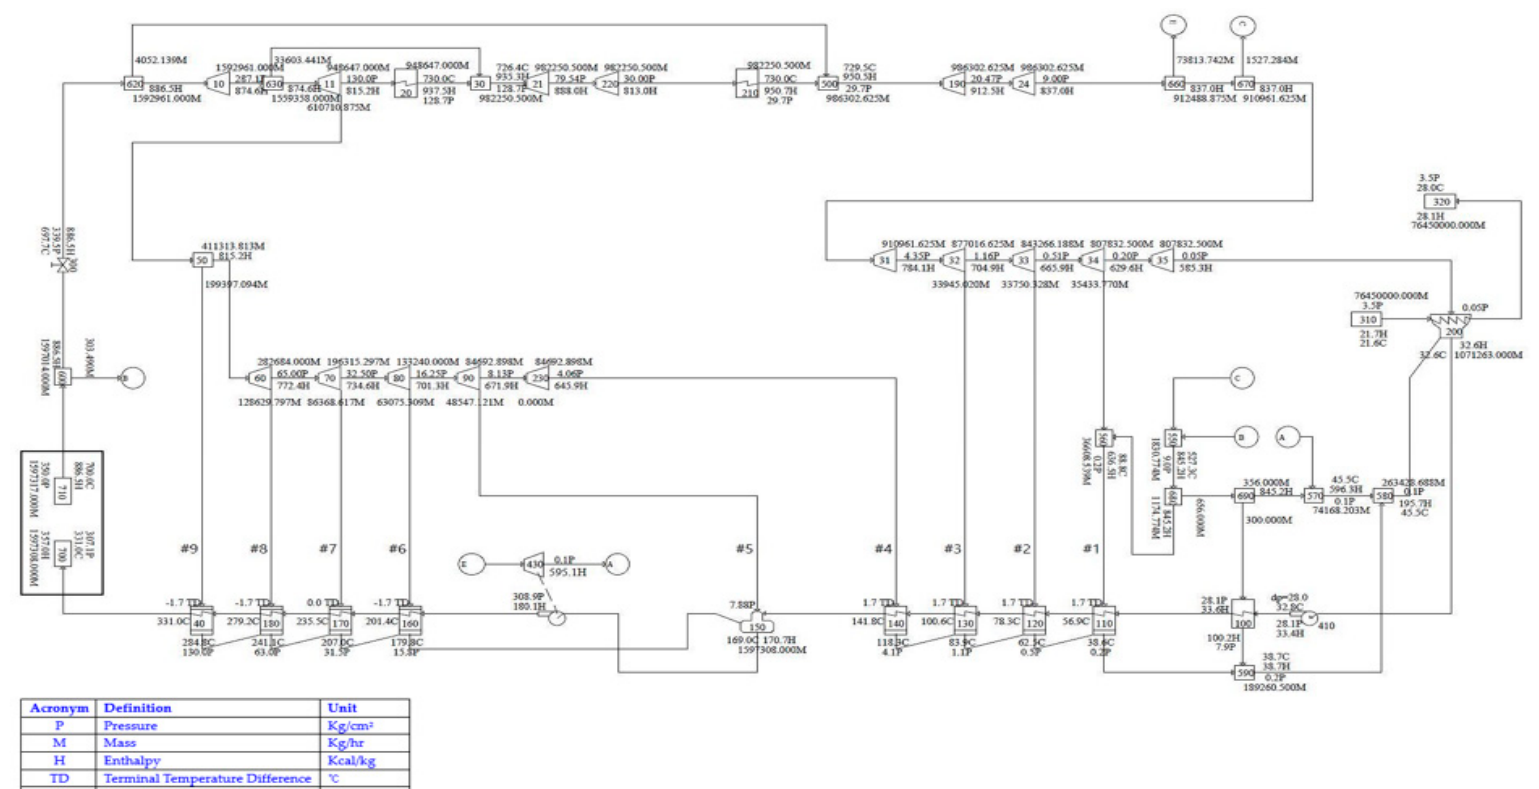
Figure 6. Simulation A-USC model (DR&9 FWH with RT 9) .